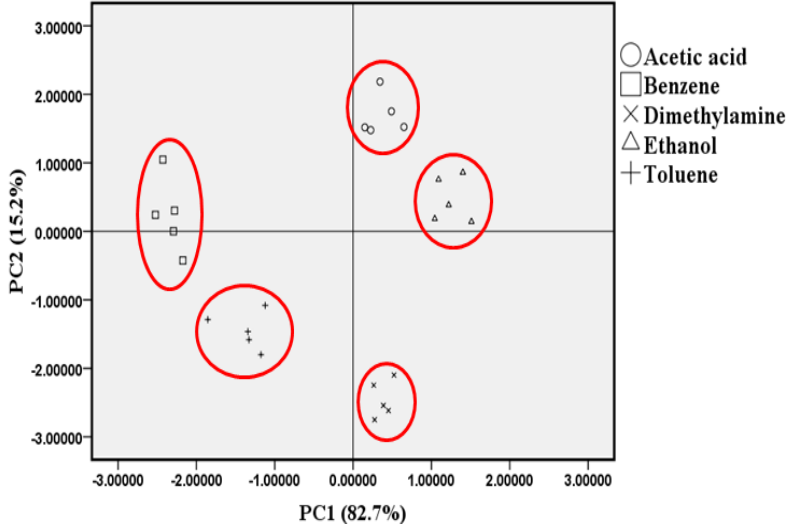
Figure 9. PCA plot of various VOC gases detected by side-polished